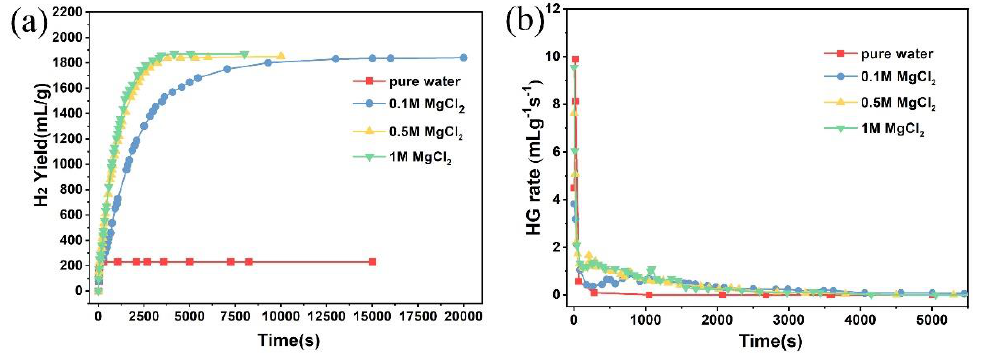
Figure 2. ( a )The hydrogen generation curves and ( b )hydrogen generation rate and hydrolysis by- product XRD patterns of MgH 2 -3 wt %LiH-G in 0.1 M, 0.5 M and 1 M MgCl 2 solutions.